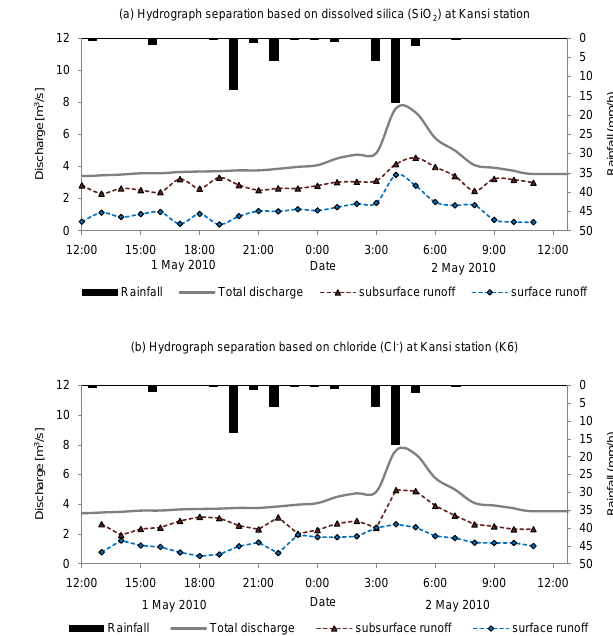
Figure 3 Hydrochemical parameter responses at Kansi station during 1-2 May 2010 storm event (a) and at Migina station during 29 April to 6 May 2011 storm event (b).